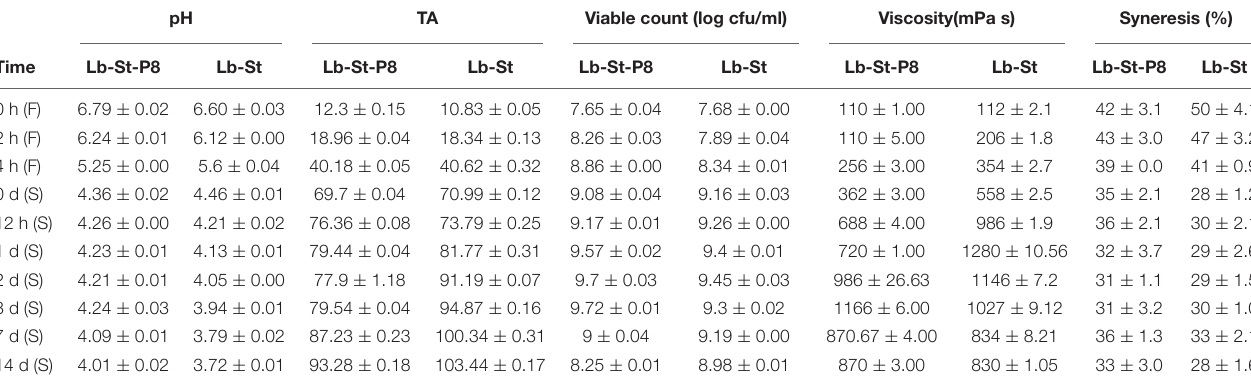
TABLE 4 | The physiochemical characteristics of milk fermented with a 1:100 ratio of L. plantarum P-8 to S. thermophilus (compared with a 1:1000 ratio of L. delbrueckii subsp. bulgaricus to S. thermophilus ) during fermentation (0, 2, and 4 h) and storage (0 h, 12 h, 1 d, 2 d, 3 d, 7 d, and 14 d). pH TA Viable count (log cfu/ml) Viscosity(mPa s) Syneresis